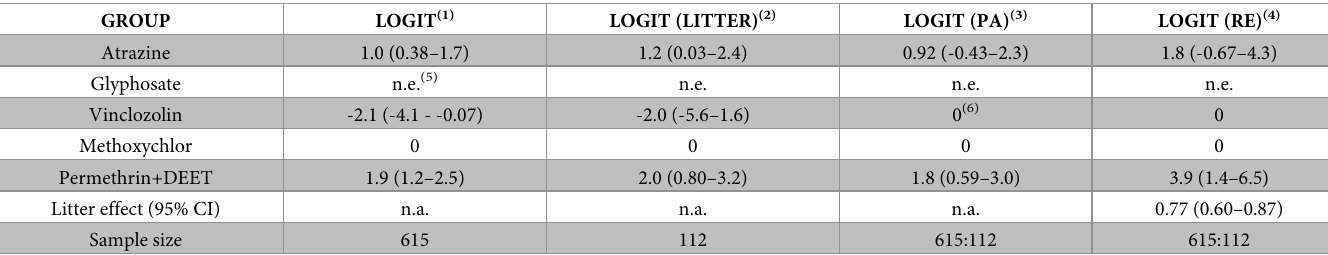
Table 3. Puberty: F3 treatment Effects (95%